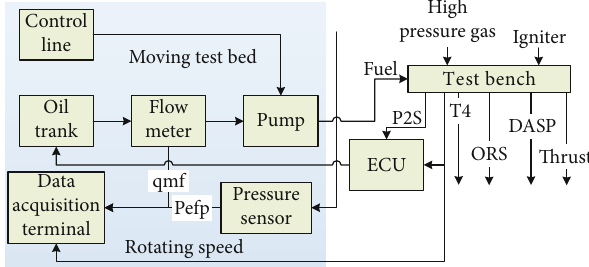
Figure 2: Schematic of engine test equipment.